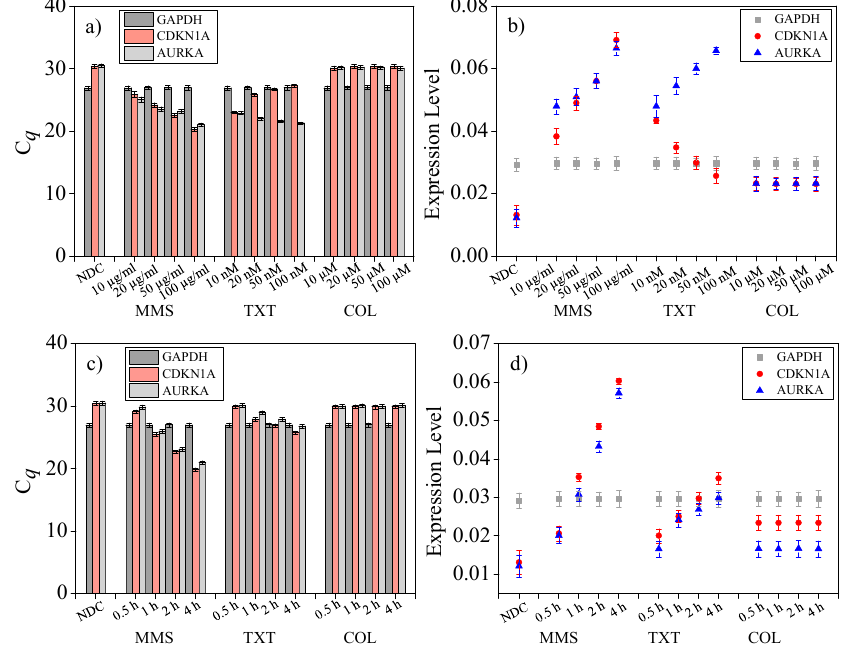
Figure 5. On-chip drug-induced single-cell genotoxicity analysis. ( a ) C q values of single-cell multiplex RT-qPCR for drug dose analysis; ( b ) Expression levels of GAPDH , CDKN1A , and AURKA genes for drug dose analysis; ( c ) C q values of single-cell multiplex RT-qPCR for drug treating time analysis; and ( d ) Expression levels of GAPDH , CDKN1A , and AURKA genes for drug treating time analysis. (NDC means ‘no drug treated control’).